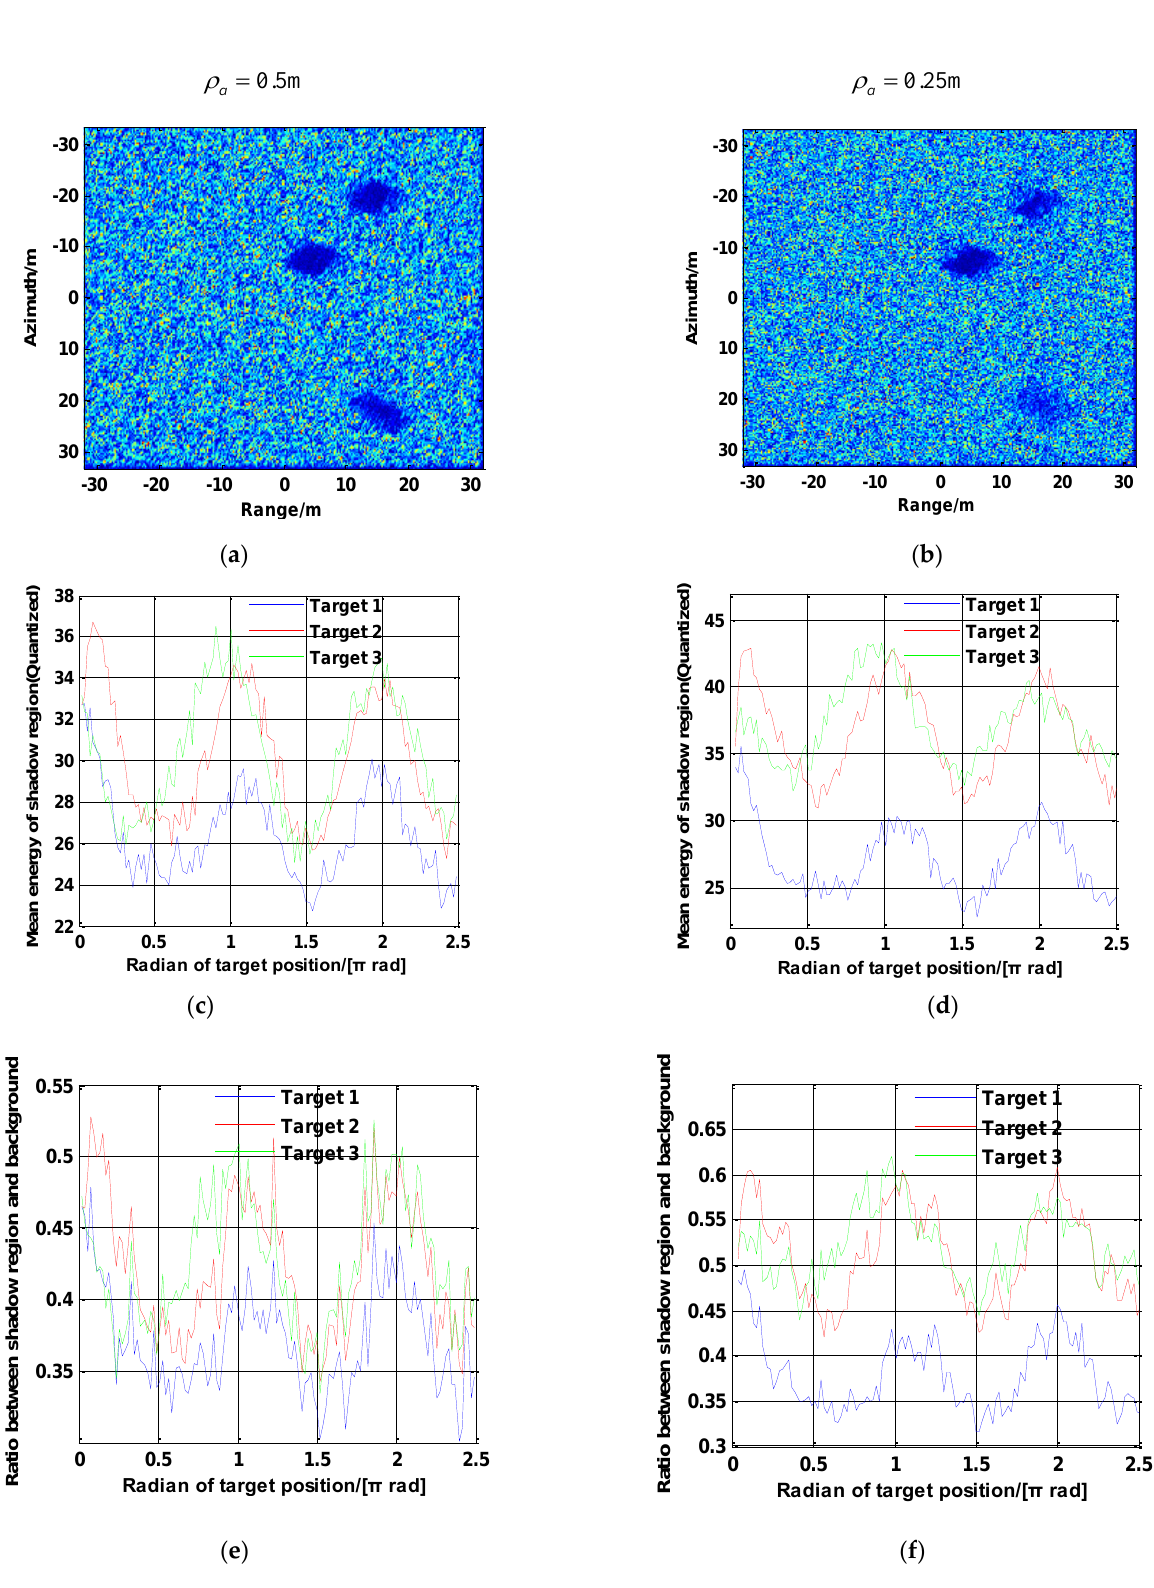
Figure 15. Results of experiment 1. ( a ) Imaging results (